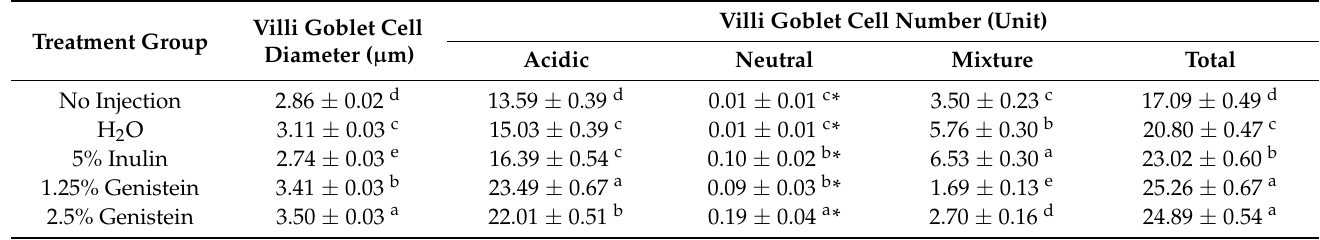
Table 5. Effects of genistein intraamniotic administration on villi goblet cells 1